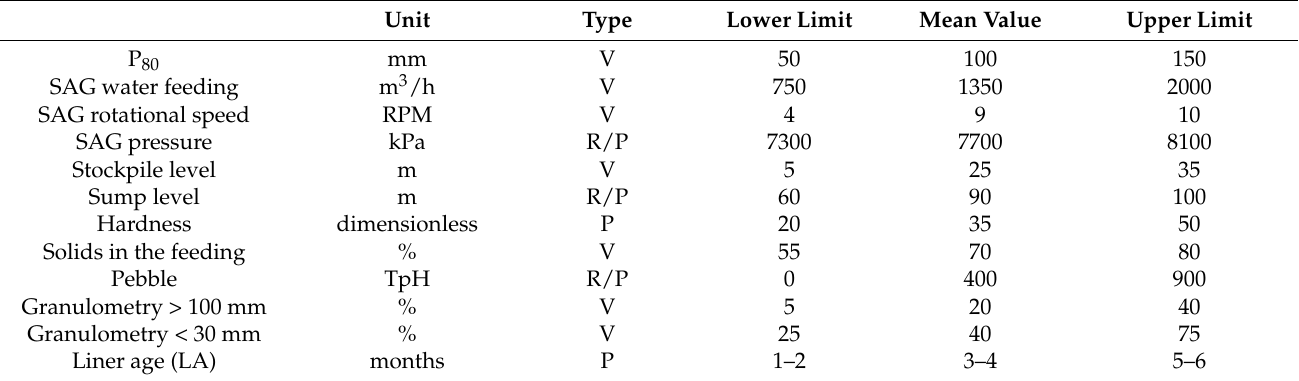
Table 1. Operational variables of the SAG grinding process (V: Variable, R: Response; P: Parameter). Unit